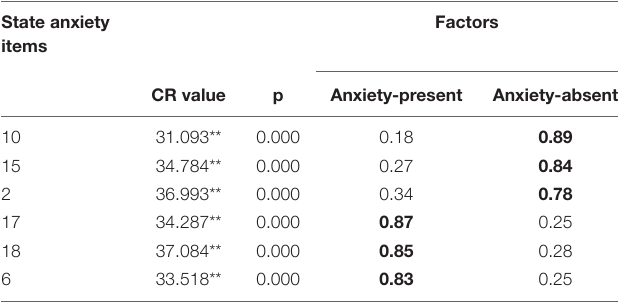
TABLE 6 | Principal axis factor analysis loading of the STAI-S-6 scale items following varimax rotation ( n = 1,142). State anxiety items